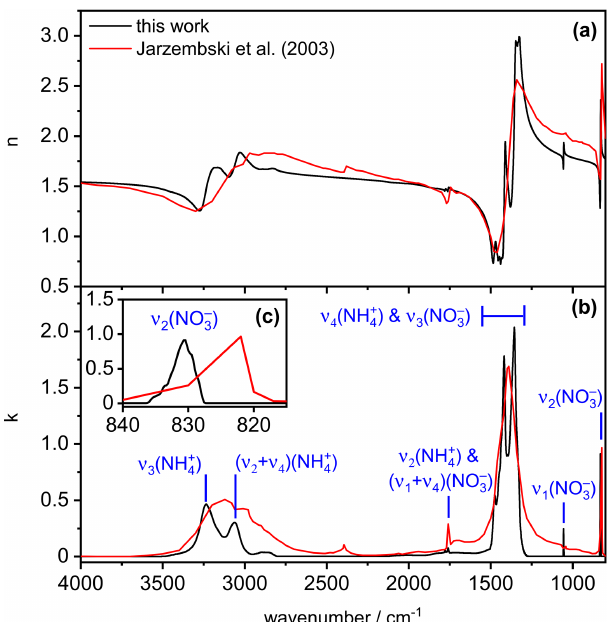
Figure 4. Real (a) and imaginary (b) parts of the complex refractive for solid AN at 223K derived from this work (black lines) in com- parison with room-temperature data from Jarzembski et al. (2003) (red lines). The insert (c) shows an expanded view of the k spectrum ) in the regime of the ν 2 ( NO − 3